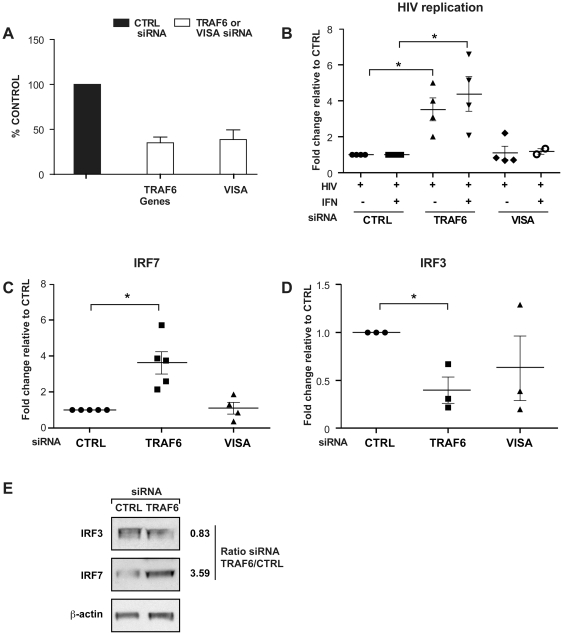

TRAF6 but not VISA controls the level of expression of IRF7 and HIV replication.Primary human macrophages were subjected to siRNA knockdown for TRAF6 and VISA. The concentration of siRNA used was 200 nM. A) Percentages of inhibition of TRAF6 and VISA in the presence of specific siRNA targeting both gene individually [n = 3] compared to a control non-targeted siRNA [n = 3]. Level of expression was measured by qRT-PCR B) Macrophages were all infected with HIV-1 with and without an IFNα2 pretreatment, and treated with specific siRNA. The level of TAT spliced message measured 24 hours post-infection in TRAF6 and VISA conditions were compared to the negative control siRNA. C) Level of IRF7 and D) Level of IRF3 message expression in the absence of IFNα2 when TRAF6 and VISA are repressed by siRNA compared to the negative control siRNA. The qRT-PCR results were normalized to the level of 18S. An * denotes a significant difference (P<0.05, one sample t-test) compared to the negative control siRNA. Each symbol in a group represents one independent donor. E) Western blot for IRF3 and IRF7, 24 hours post-infection in macrophages with TRAF6 suppression compared to siRNA control. The densitometry of the bands was normalized to that of β-actin and shows a decrease in protein level of IRF3 and an increase of IRF7. The ratio is shown next to the respective panels. Results shown are representative of 3 independent experiments.